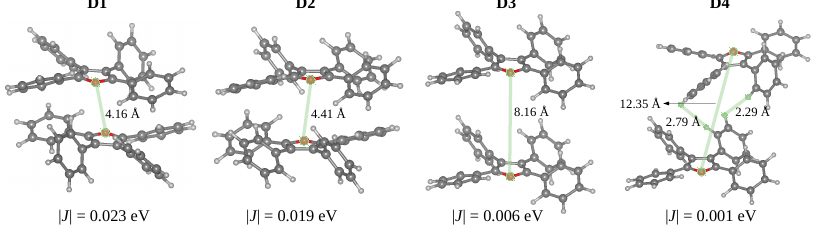
Figure 5. Structures of dimers in the TPF showing closest intermolecular contacts (Å) and absolute values of the exciton couplings (in eV).